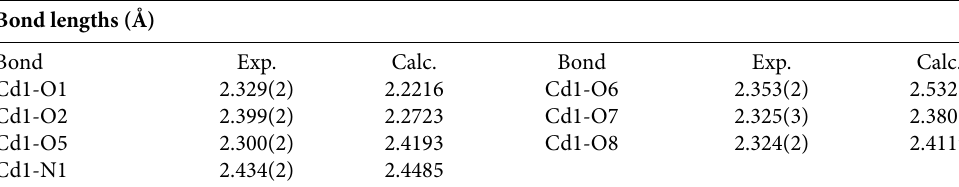
Table 2. Selected experimental and calculated coordination bonds and angles of [Cd(IsoPht)(TEA)H 2 O]·3H 2 O Bond lengths